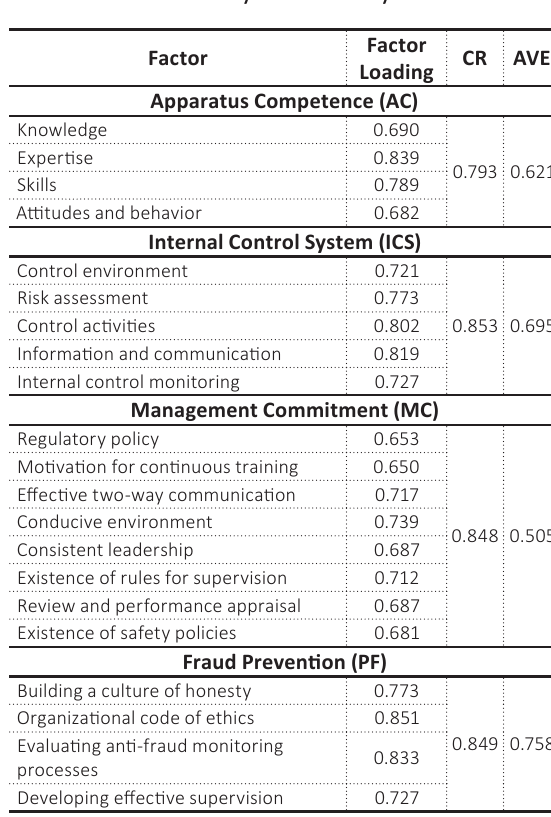
Table 4. Confirmatory factor